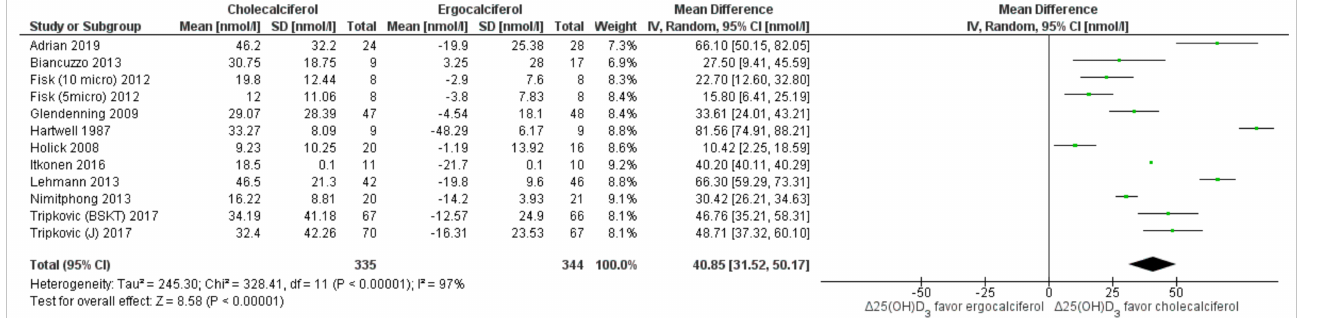
Figure 6. Forrest plot for 25(OH)D 3 . Legend: Forrest plot of random effect meta-analysis comparing the effects of cholecal- ciferol vs. ergocalciferol supplementation on net changes in 25(OH)D 3 concentrations favored cholecalciferol. “ ∆ 25(OH)D 3 ” denotes the change in 25(OH)D 3 concentrations from baseline (net change), squares denote the mean differences (with 95% confidence interval), i.e., the pooled results indicate mean difference of 40.85 nmol/L with 95% confidence interval of 31.52 to 50.17 nmol/L, favoring cholecalciferol supplementation. However, the studies are highly (significantly) heterogeneous ( I 2 = 97%).